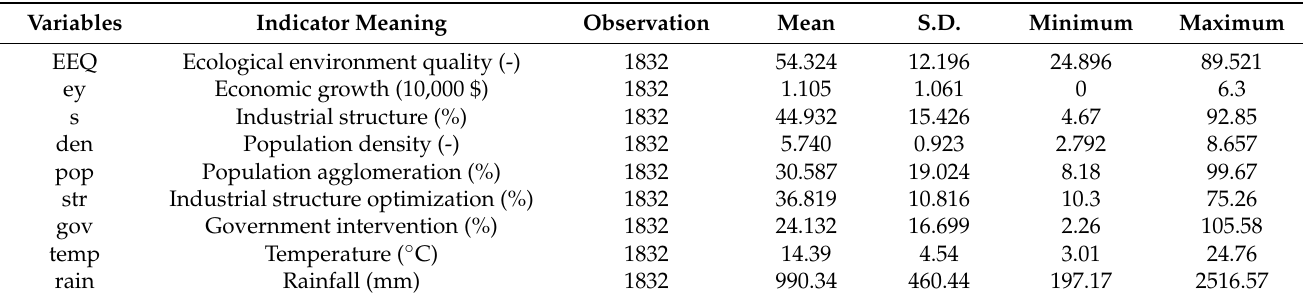
Table 2. Descriptive statistics of